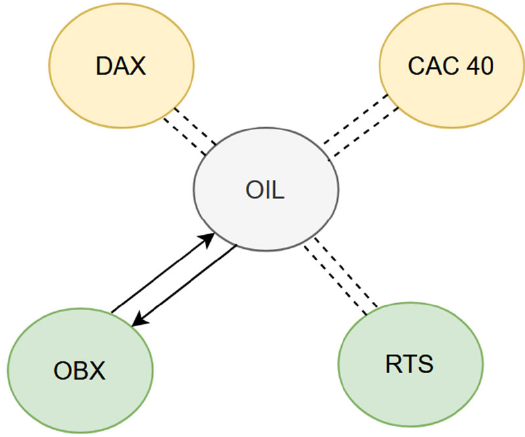
Figure 2. Granger causality results (pre-COVID-19 period).